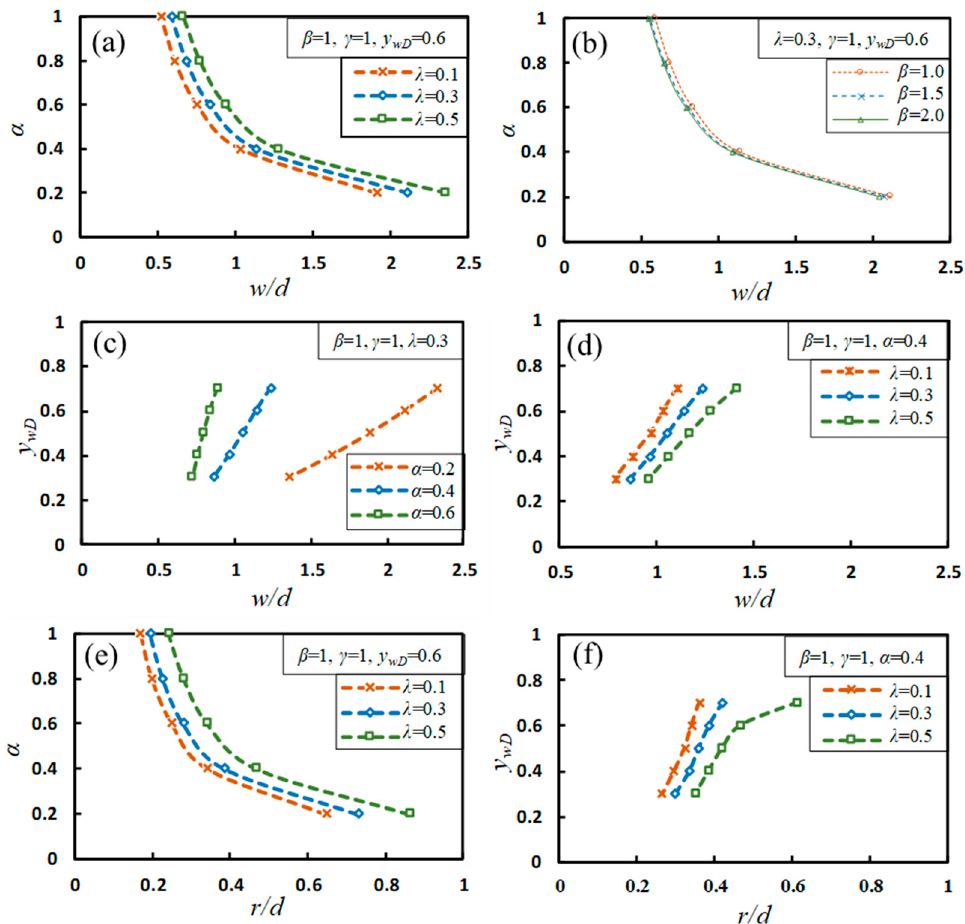
Figure 10. Dependency of dimensionless shape factors on control parameters for x wD = 0 in the type-I catchment zone: ( a ) Curves of w / d versus α with different λ values; ( b ) Curves of w / d versus α with different β values; ( c ) Curves of w / d versus y wD with different α values; ( d ) Curves of w / d versus y wD with different λ values; ( e ) Curves of r / d versus α with different λ values; ( f ) Curves of r / d versus y wD with different λ values.